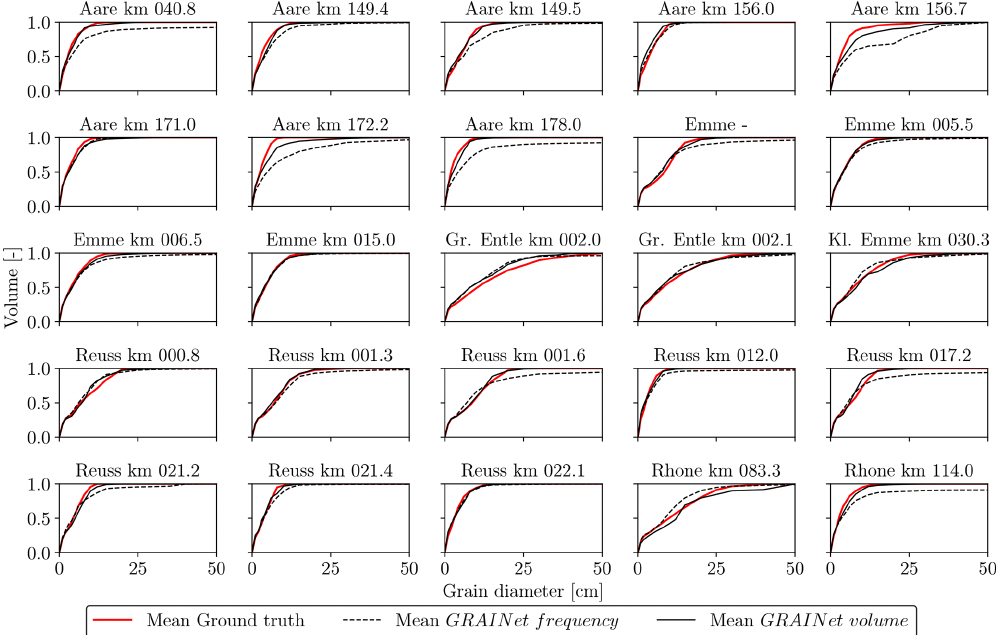
Figure 18. Grading curves of the 25 gravel bars, estimated with geographical cross-validation.